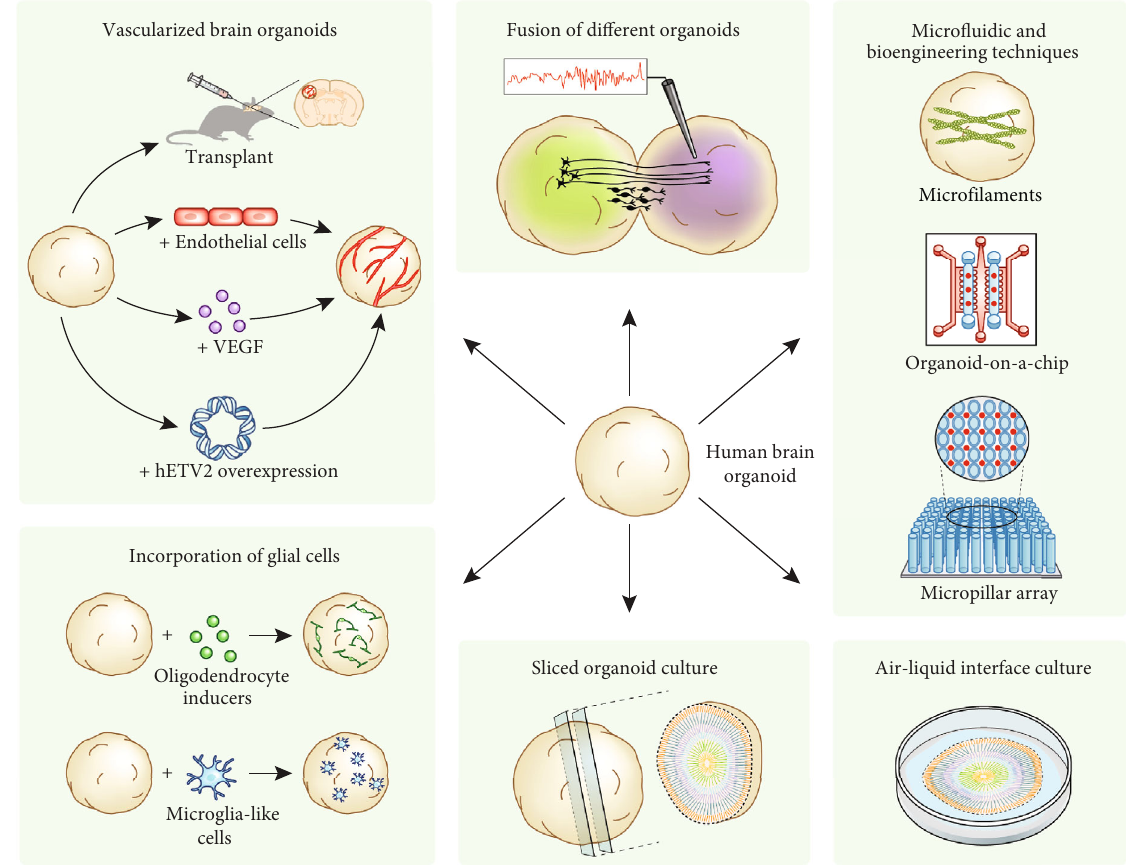
Figure 1: Recent advances of brain organoid techniques. (1) Di ff erent region-speci fi c brain organoids can be fused together to generate so- called “ assembloids ” for the investigation of interregional interactions. (2) The lack of oligodendrocytes and microglia in cortical organoids has inspired the incorporation of these cell types into brain organoids. Strategies include exposure to oligodendrocyte inducers and coculturing with microglia-like cells. (3) The addition of vasculature in brain organoids is bene fi cial for oxygen and nutrient delivery under long-term culturing and hence the development of vascularized brain organoids. Strategies include transplantation of brain organoids into the mouse brain, coculturing with endothelial cells, exposure to vascular endothelial growth factor (VEGF), and overexpression of human ETS variant 2 (ETV2) in brain organoids. (4) Air-liquid interface culture technique has been shown to bene fi t neuronal survival and axonal growth. (5) Sliced organoid culture technique is able to overcome the di ff usion limit in conventional brain organoid culture, leading to more expanded cortical plate and distinct layering of neurons. (6) Micro fl uidic and bioengineering techniques help improve the repeatability and uniformity of brain organoid culture, providing possibilities for generating organoids with simple procedure, high reproducibility, and low